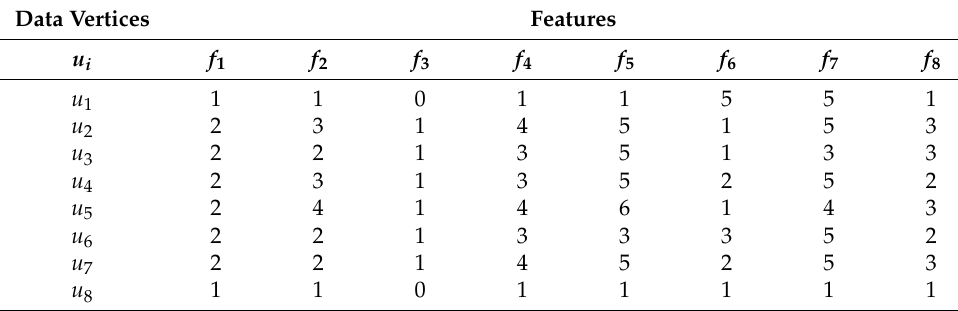
Table 3. Feature vectors of data vertices of data graph Figure 1. Data